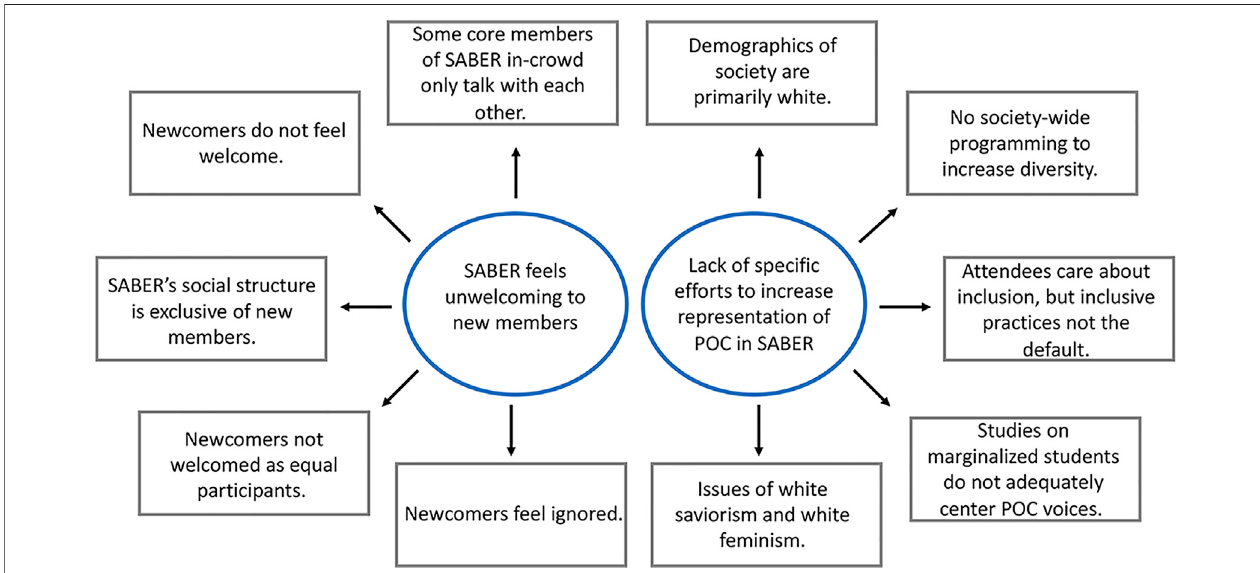
FIGURE1| ThemesderivedfromSABERattendeesurveyresponsesfrom2019inresponsetothequestion: “ InwhatwayshasSABERnotfullypracticeddiversity, equity, and inclusion? ” Themes are shown in blue circles and sample comments from these themes are shown in